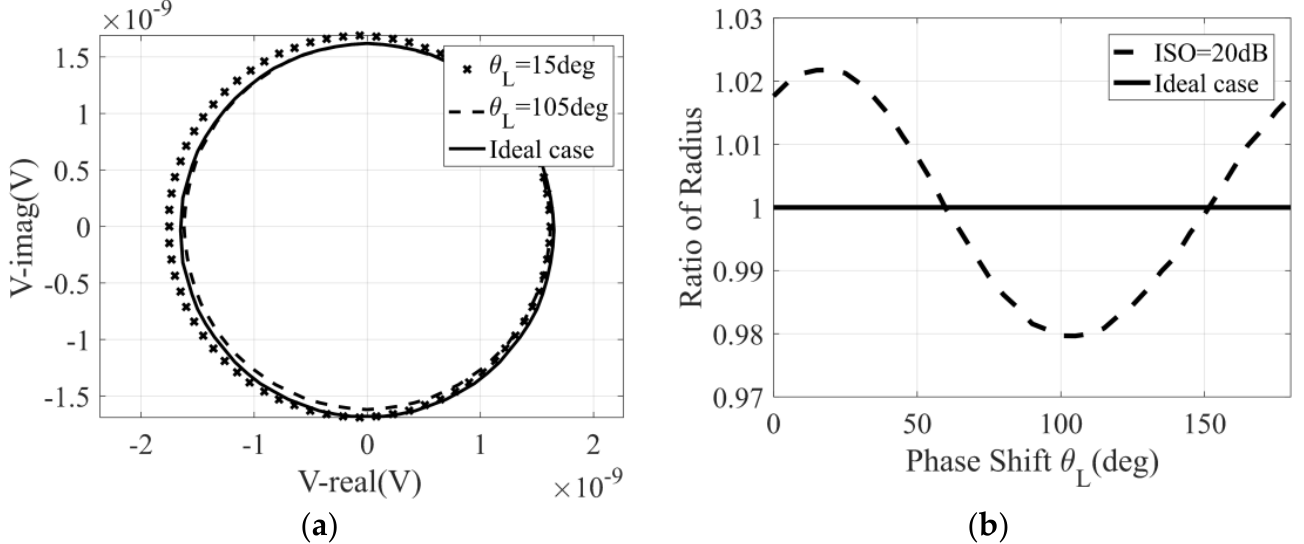
: ( a ) correlation 𝑙